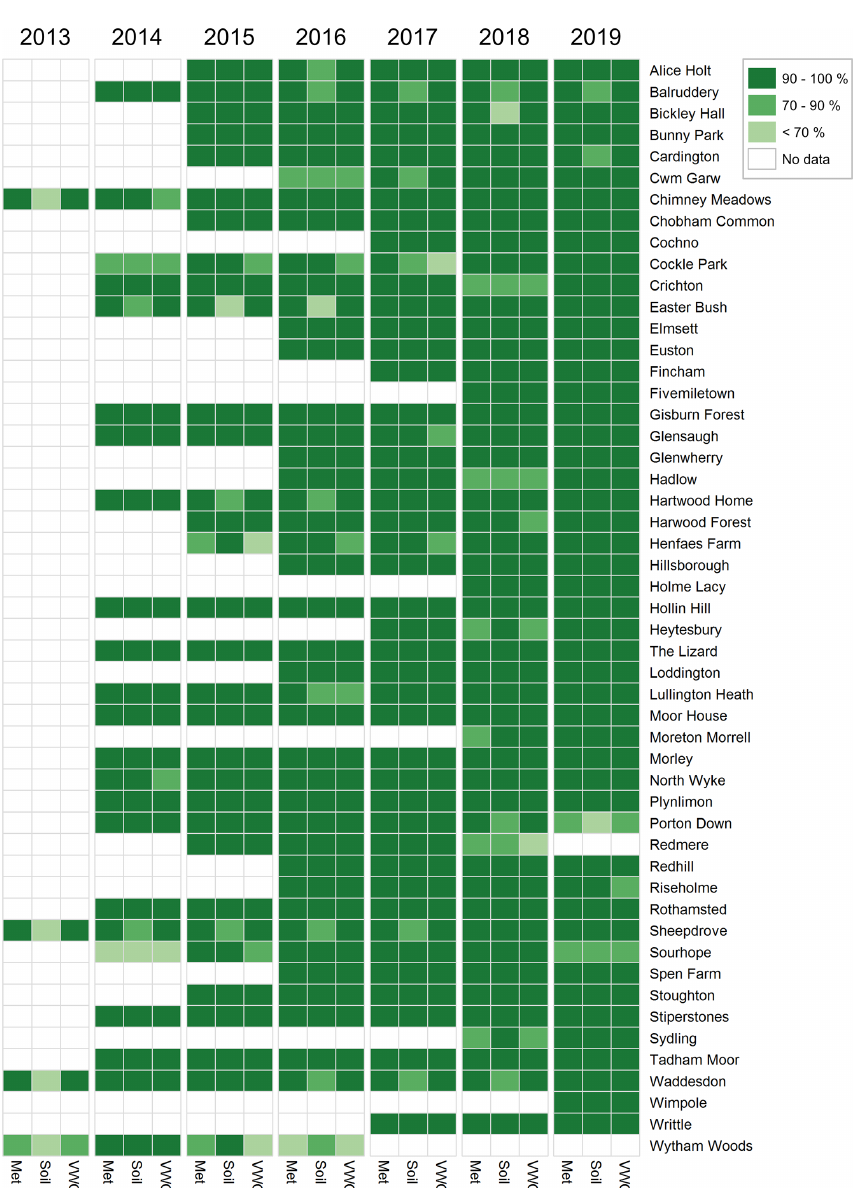
Figure 10. Data completeness for the Stanley et al. (2021) COSMOS-UK dataset. “VWC” is the CRNS VWC data, “Soil” consists of data from buried point and profile soil moisture sensors, and “Met” comprises meteorological variables.